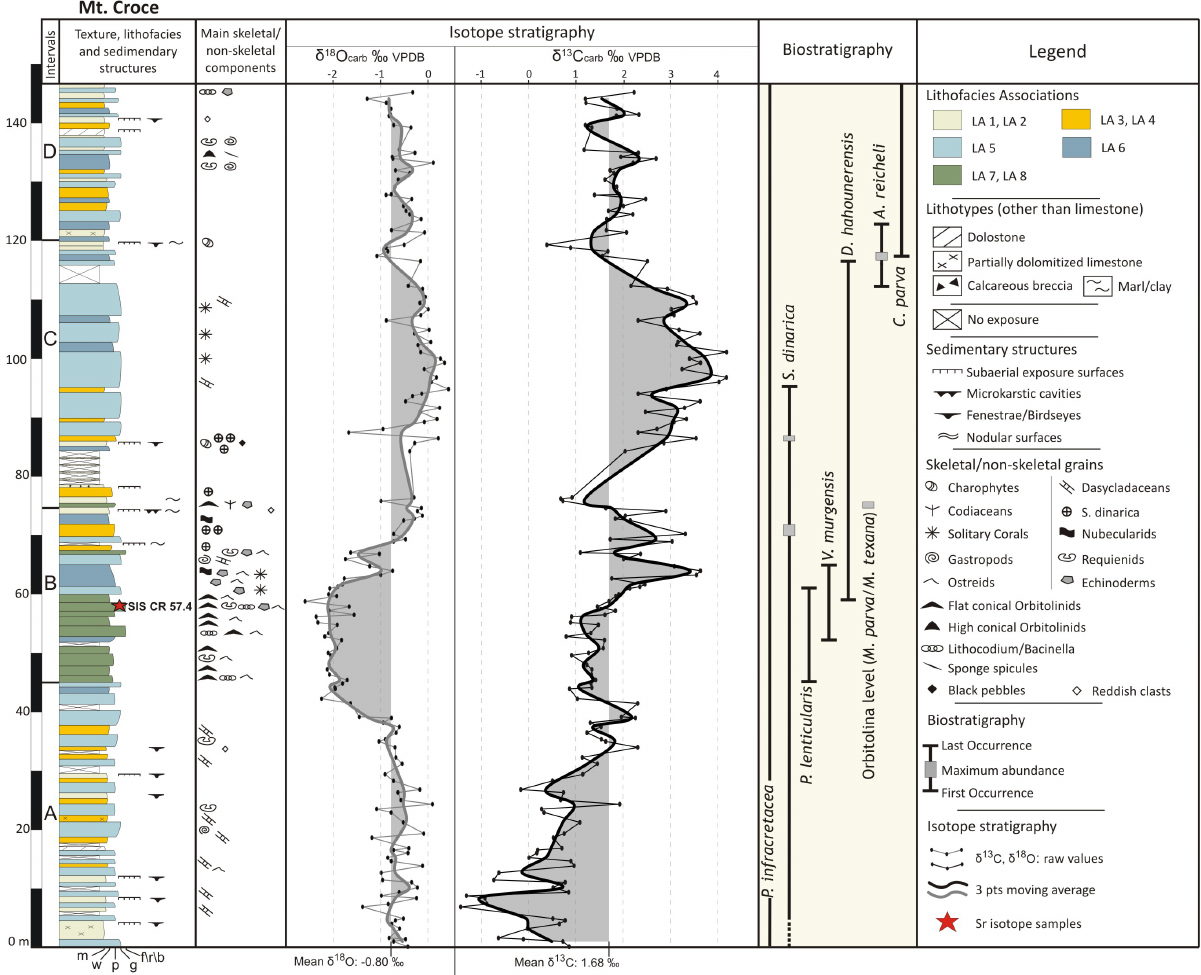
Fig. 8. Mt. Croce section: lithological–sedimentological log, isotope stratigraphy and biostratigraphy. The thick curves represent the 3-point moving averages of O- (grey) and C-isotope ratios